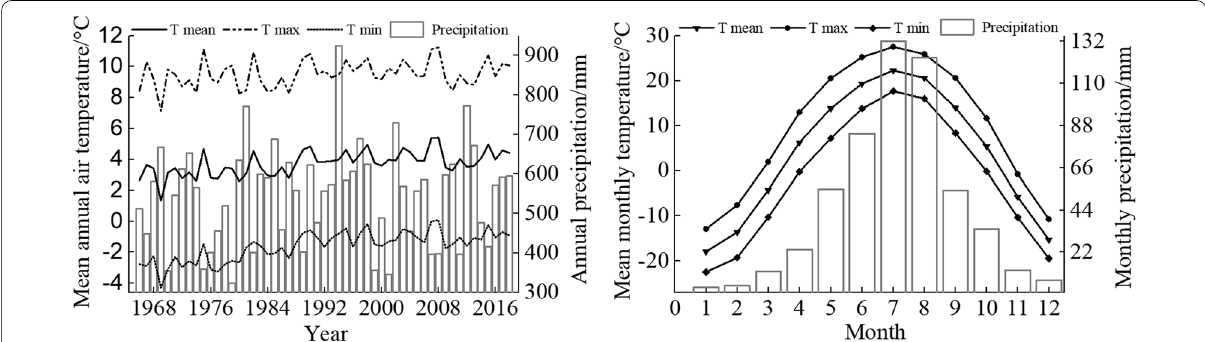
Fig. 4 Interannual (left) and monthly (right) variations of temperatures (mean, maximum, minimum) and precipitation in Dongzhelenghe Nature Reserve from 1966 to